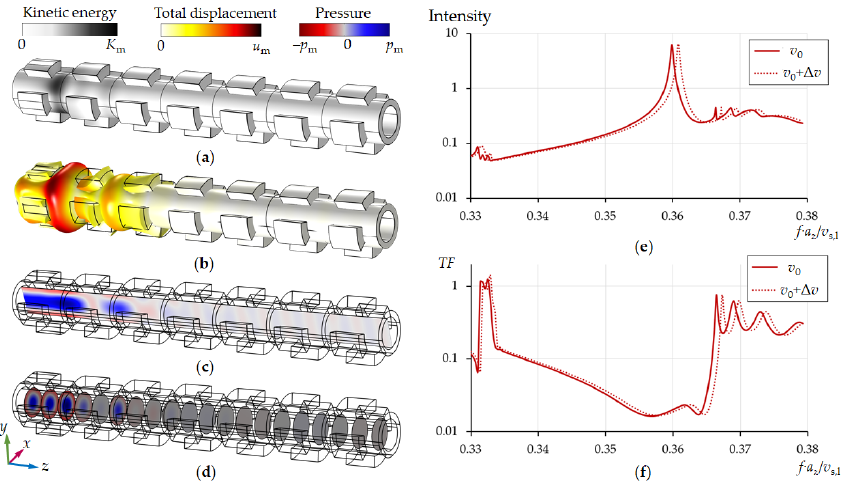
Figure 3. Propagation of acoustic waves along a pipe with a periodic structure of sectioned rings from left to right ( a – d ), the intensity of acoustic waves in the first unit cell ( e ) and the transmission spectra for two sound velocities of water ( f ). The inner diameter of pipe is d in = 353 μ m. Lattice period of a tubular phononic crystal is a z = 2 d in . The calculations were performed for v 0 = 1481 m/s, Δ v = 5 m/s. In Figure 3e,f the frequency scale is normalized by multiplying by the lattice constant and dividing by the longitudinal speed of sound in solid ( s,l v ), which is associated with the mechanical properties of a solid in the Equation (6):